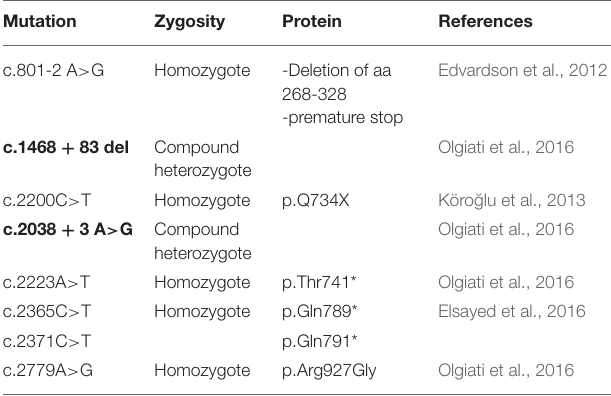
TABLE 2 | Mutations in auxilin (DNAJC6) associated with Parkinson’s